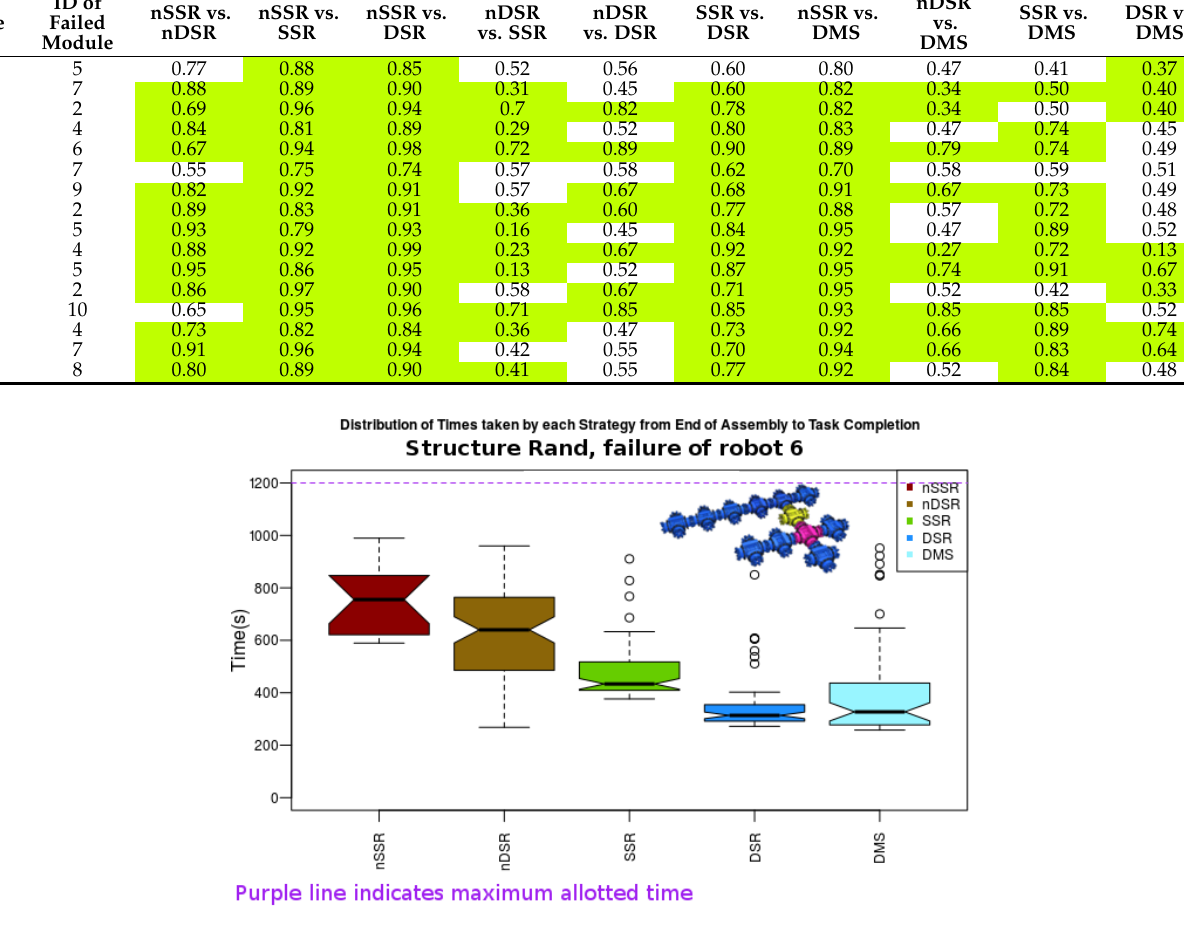
Figure 13. When robot 6 failed in structure Rand, dynamic-self-repair methods allow faster task completion than comparable static strategies. Substructure based self-repair also provides a speed advantage over naive breakup